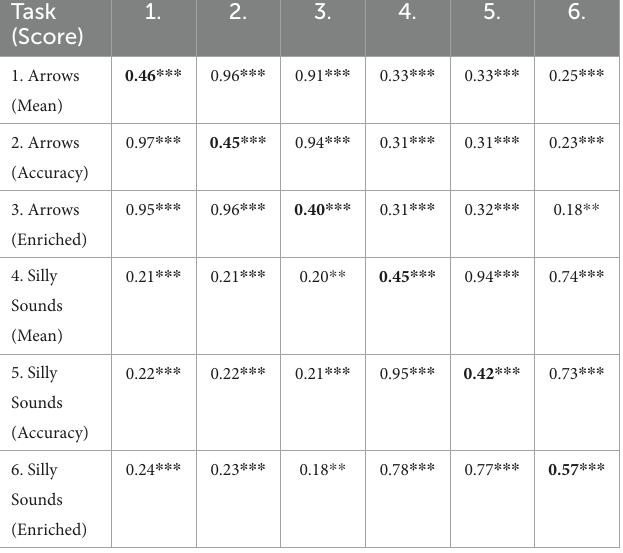
TABLE 4 Bivariate correlations between inhibitory control task scores. TABLE 3 Final standardized loadings from the enriched silly sounds stroop